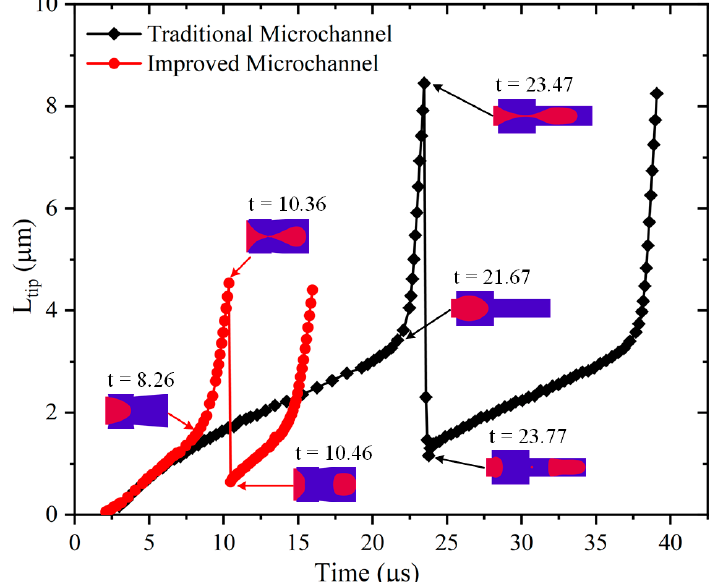
Figure 11. Variation of tip length with time during formation of microbubbles in two